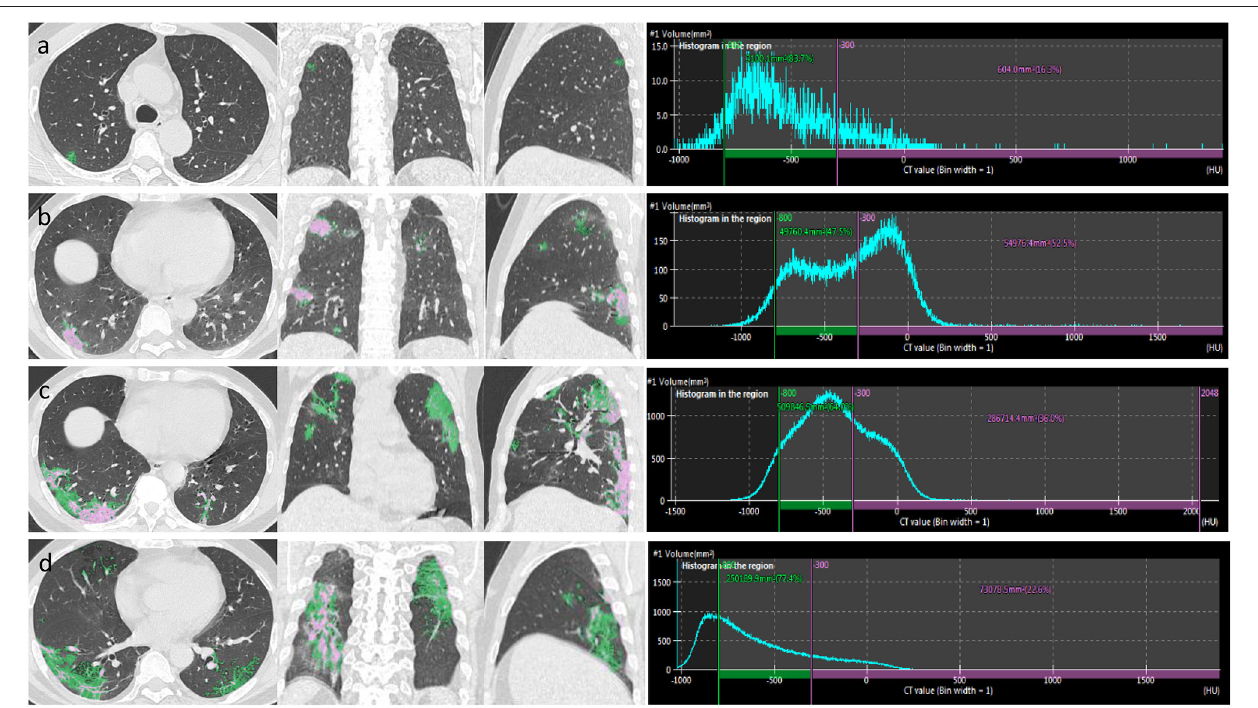
FIGURE 4 | After the segmentation of infected regions, automatic extraction of GGO and consolidation was performed in a patient with COVID-19 pneumonia. By thresholding on CT values in the pneumonia lesions, GGO (green area) and consolidation (pink area) were identified with the value range of − 800 to − 300 and > -300 HU, respectively. The figure shows axial, coronal, and sagittal multiplanar reconstruction views (left to right) of GGO and consolidation in the early stage (a) , progressive stage (b) , peak stage (c) , and absorption stage (d) .